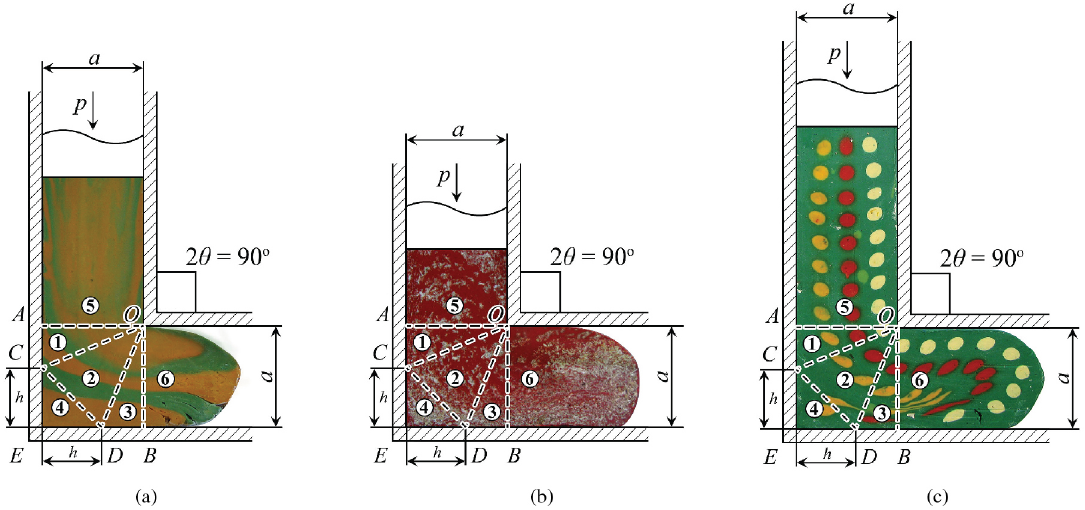
Figure 1. Physical simulation of material flow during ECAE using plasticine: layered sample (a), marker techniques (b), and gridline technique